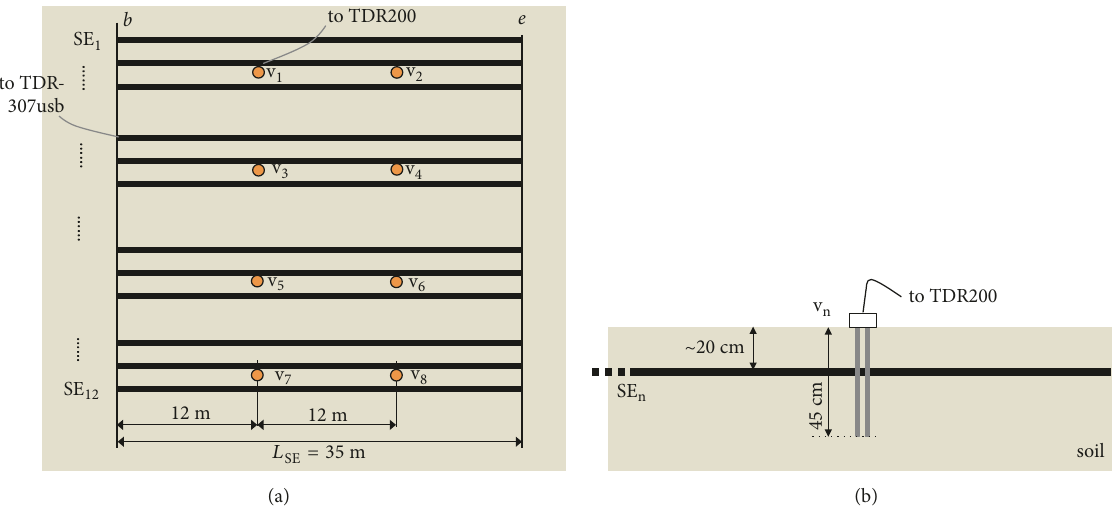
Figure 3: Experiment #2: (a) top-view schematization of the experimental setup. SE 1 ,. .. , SE 12 indicated the sensing element. v 1 , .. ., v 8 indicate the vertical local probes. (b) Longitudinal section in correspondence of one of the SEs. Dimensions not to scale.